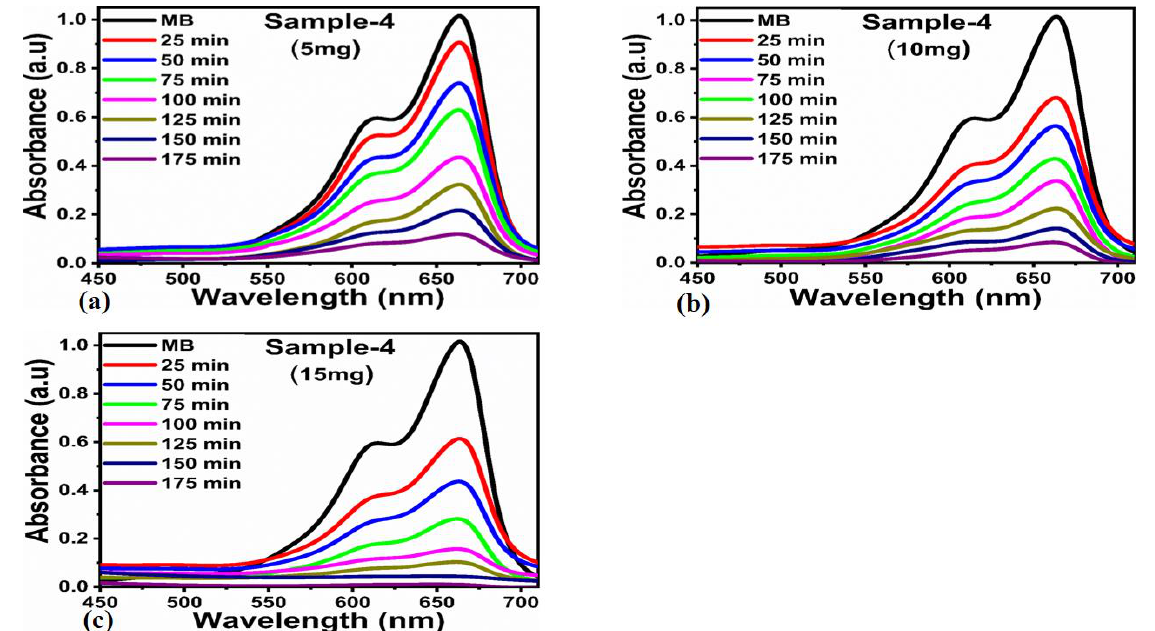
Figure 11. ( a – c ) UV-visible absorption spectra of photodegradation of 6.12 × 10 −5 M) MB solution using various catalyst doses such as 5 mg, 10 mg, and 15 mg of sample-4.